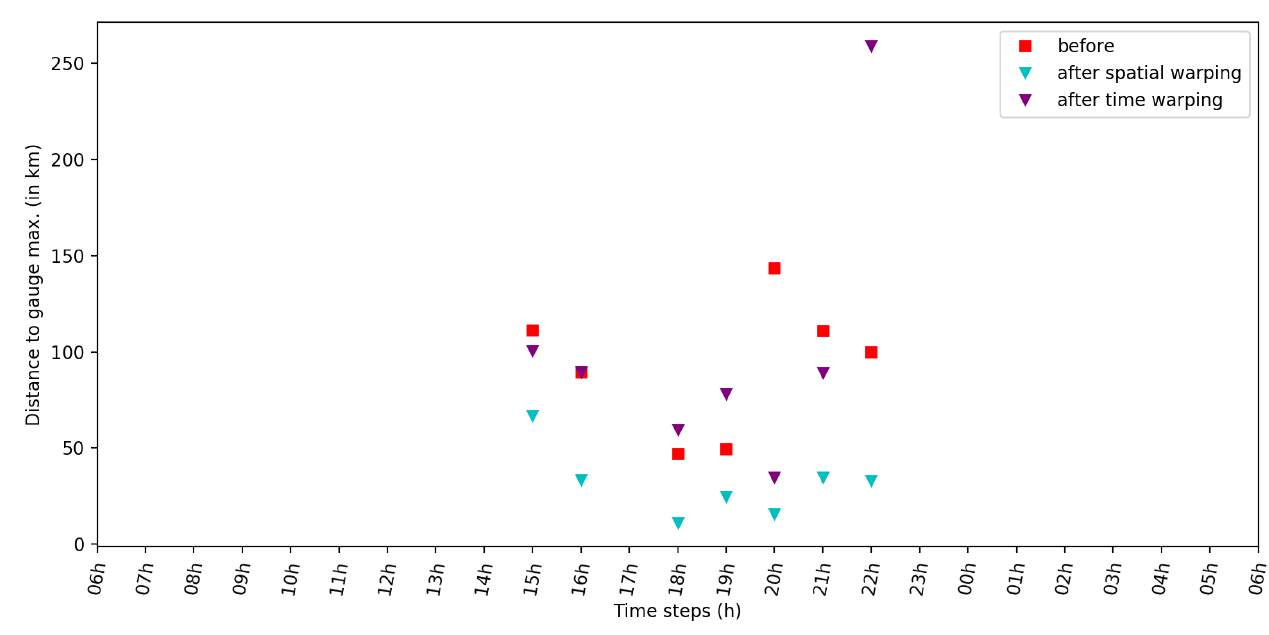
Figure 16. Distance between the “true” peak (gauge) and the estimated ones before and after warping, for the “All” experiment, at each time step with more than 1 mm/h of recorded rainfall (in v